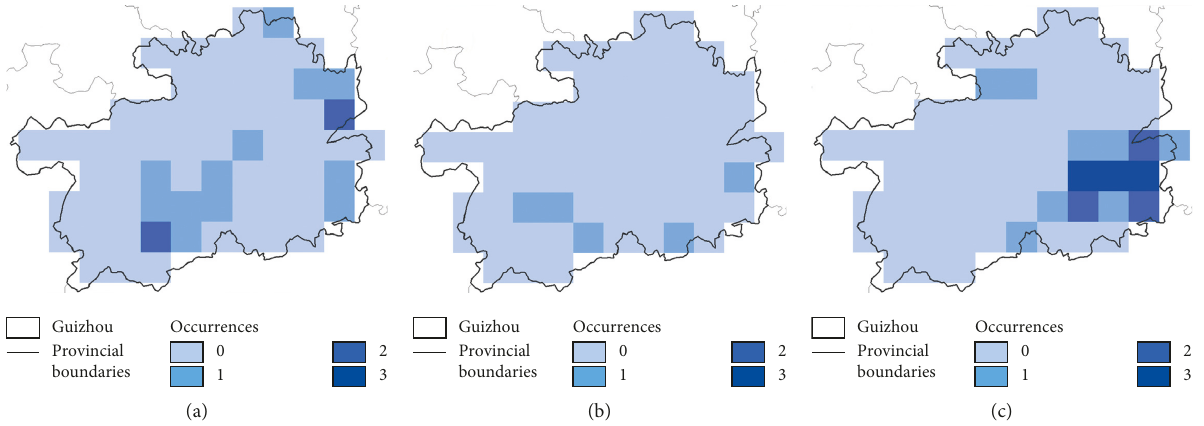
Figure 20: Spatial distribution of the frequency of drought-flood abrupt alternation events in Guizhou from 2019 to 2050. (a) RCP2.6. (b) RCP4.5. (c)